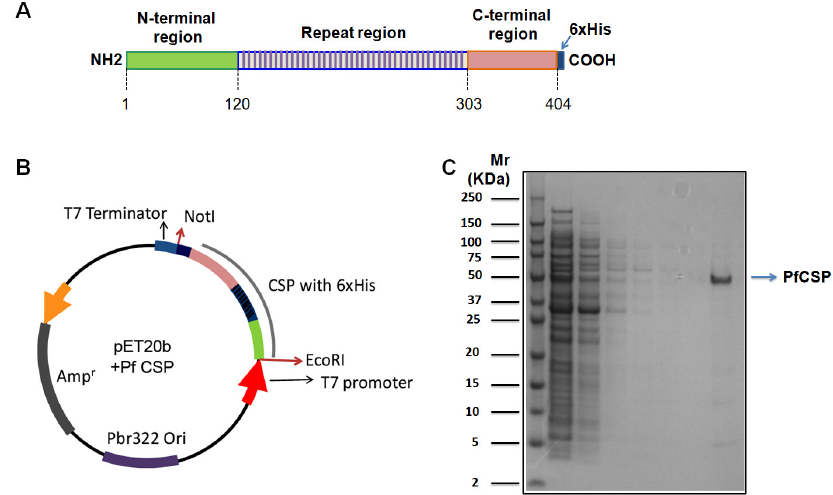
Figure 1. Expression and purification of a recombinant P. falciparum circumsporozoite protein (PfCSP). ( A ) Schematic representation of the recombinant PfCSP. Pf CSP coding sequence excluding C-terminal glycosylphosphatidylinositol (GPI) anchor, composed of N-terminal, central repeat, and C-terminal regions, was fused with 6XHis tag at its C-terminus, and cloned into pET20b vector (Stratagene, La Jolla,